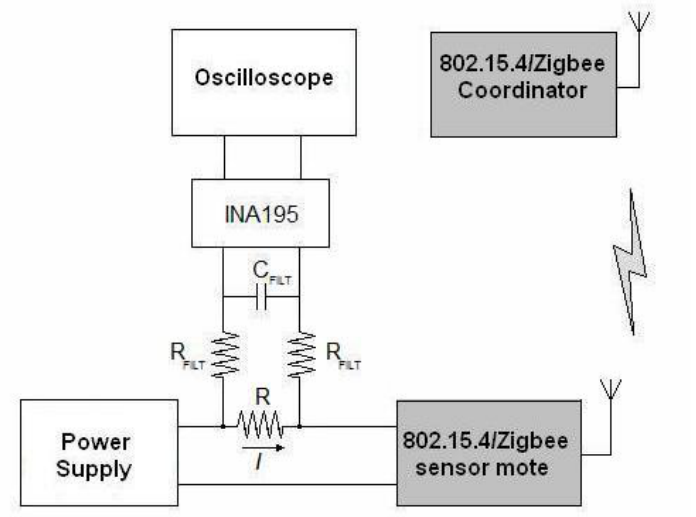
Figure 1. Experimental setup for the measurements of battery